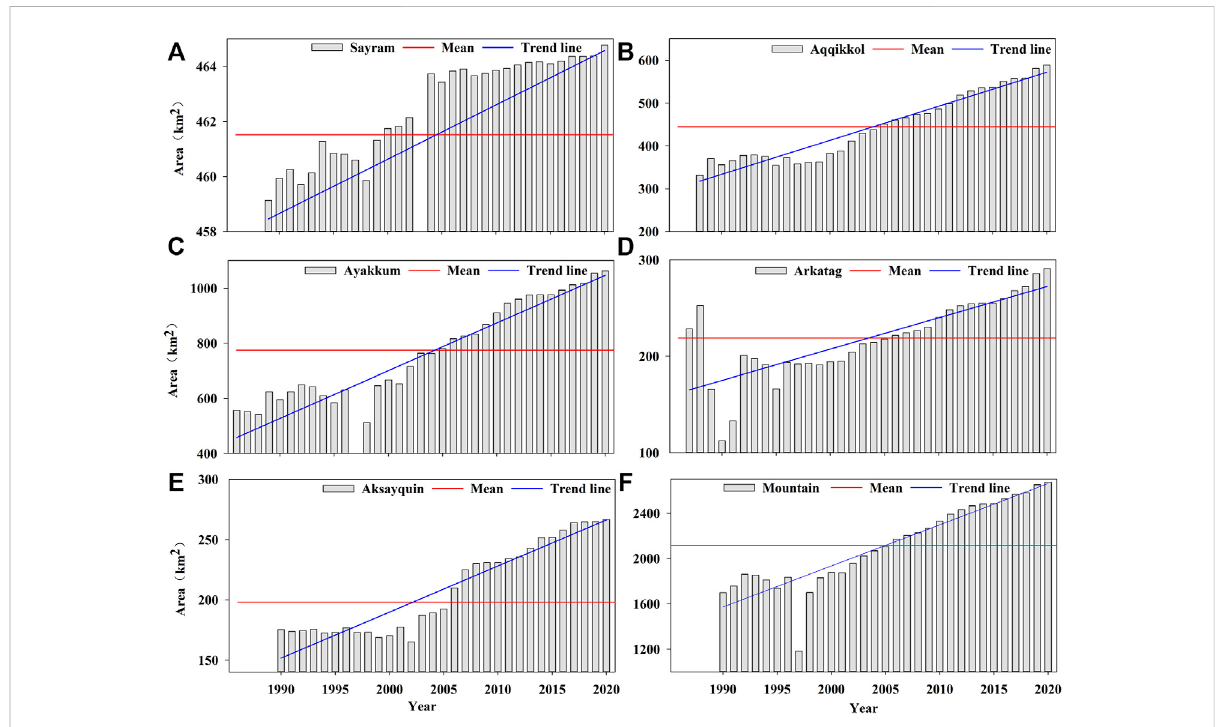
FIGURE 4 AreachangesoftypicalmountainlakesinXinjiangfrom1986to2020 (A) LakeSayram; (B) LakeAqqikkol; (C) LakeAyakkum; (D) LakeArkatag; (E) Lake Aksayquin; (F) the mountain